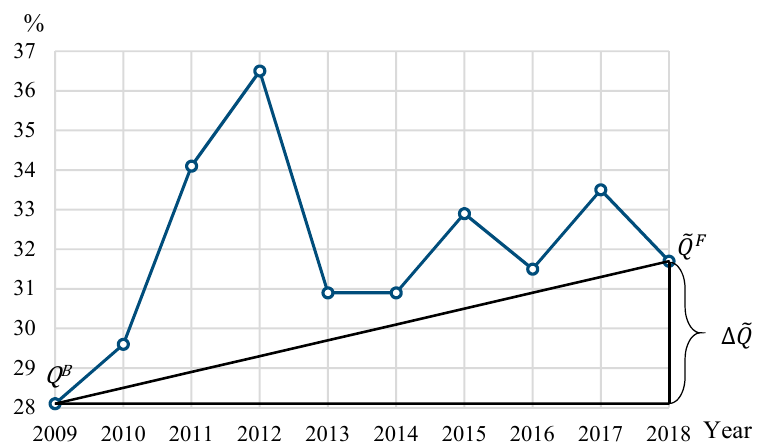
Figure 7. Energy development in other (miscellaneous) sectors in Greece over the 2009–2018 period (source: compiled by the authors).